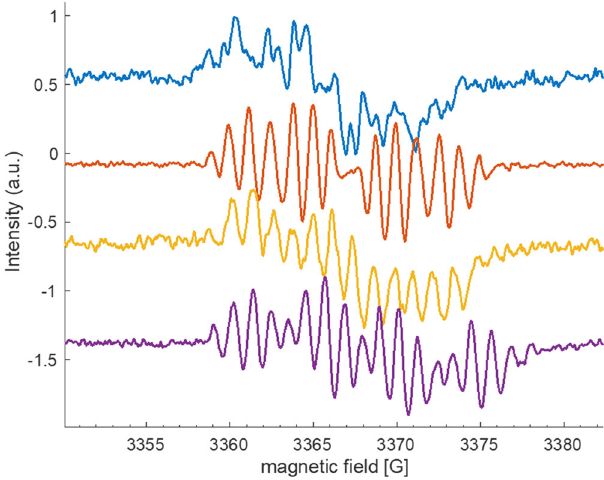
Fig. 5 EPR spectroscopy. EPR spectra of BTI (blue line, g = 2.0033, aH (G) = 2.3; 2.2; 2.2; 1.85; 1.6; 1.6; 1.3; 0.5), T1 (red line, g = 2.0044, aH (G) = 4.9; 2.88; 2.45; 1.44; 1.44; 1.08; 1.08; 1.08), T2 (orange